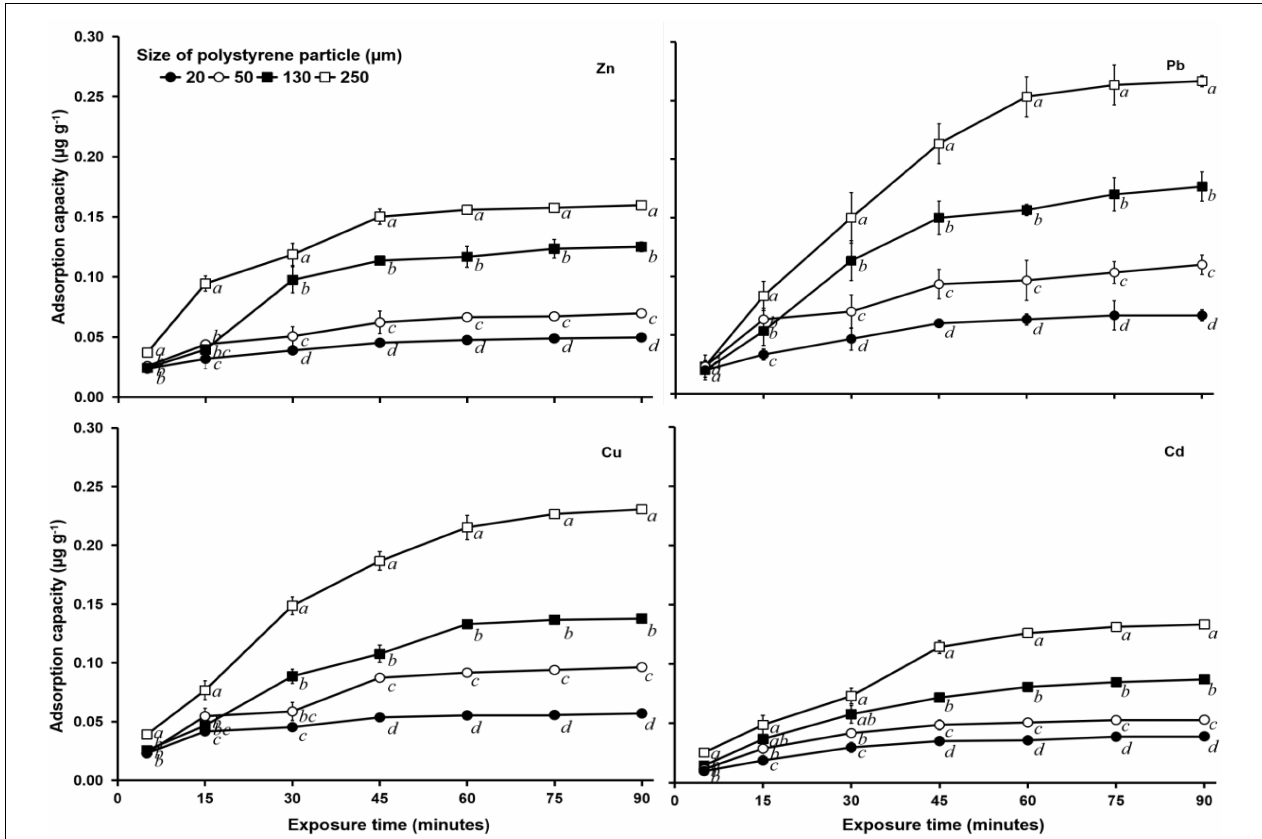
FIGURE 1 | Heavy metal (Zn, Pb, Cu, and Cd) adsorption capacity ( µ g g − 1 ) of PS of different sizes (20, 50, 130, and 250 µ m) with a 1 mg L − 1 heavy metal concentration and 0 salinity. Data for the adsorption capacity ( µ g g − 1 ) of the same heavy metal with different letters (a, b, c, and d) are significantly different ( p < 0.05) between each PS (cid:104)